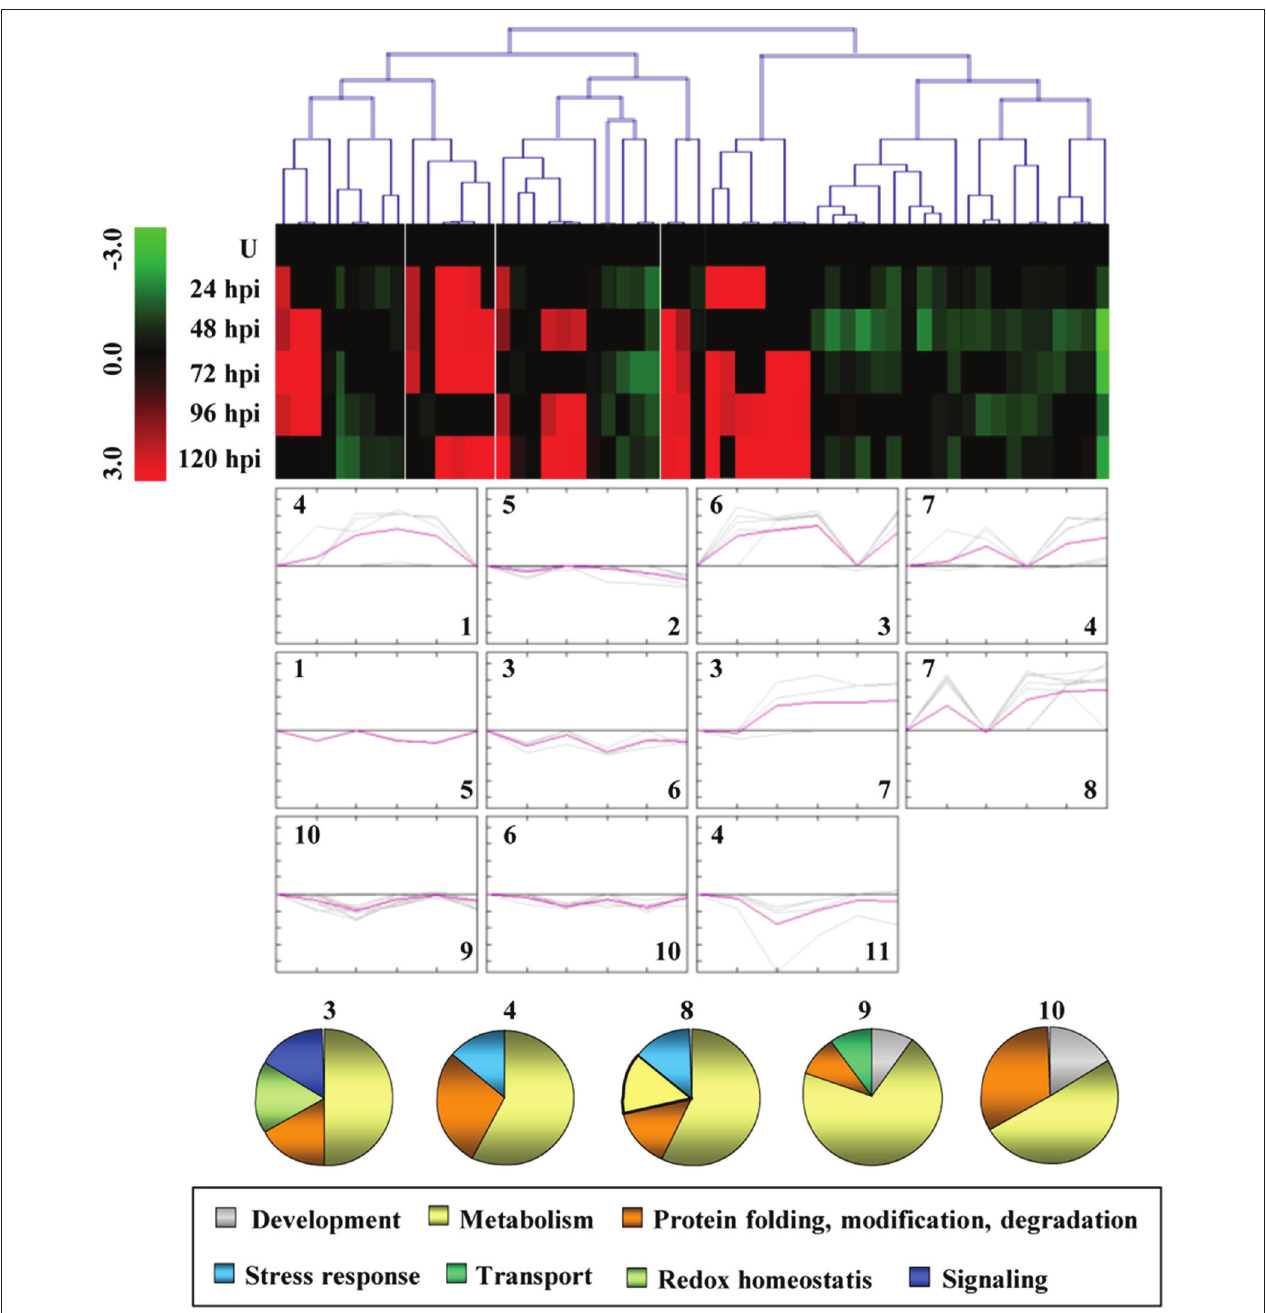
FIGURE 2 | Clusterogram of PSRPs. Fifty-six identified PSRPs were grouped into 11 clusters based on their expression pattern. The SOTA cluster tree is shown at the top, and the expression pattern in clusters are shown below. High (or low) abundance ranges from pale to saturated red (or green). U,